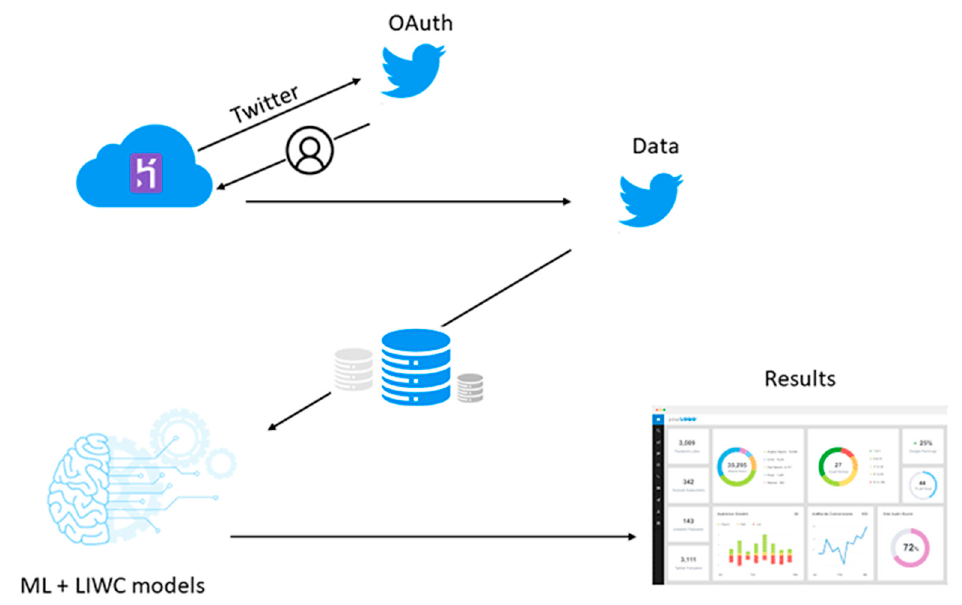
Figure 4. Architecture for the implementation of the personality prediction model based on the behavior of a person on Twitter in a WEB portal.